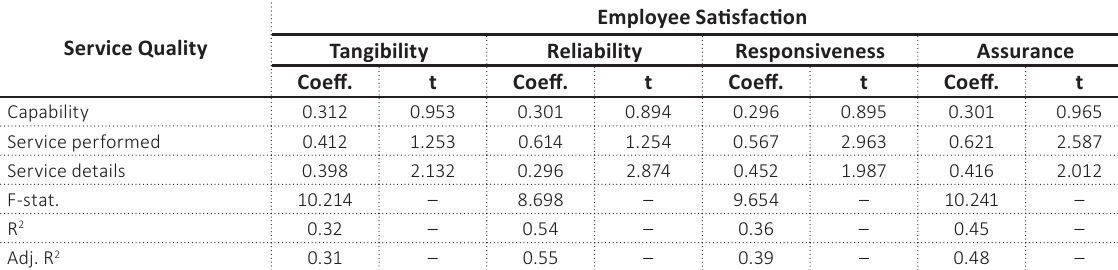
Table 6. Test of the second hypothesis Service Quality